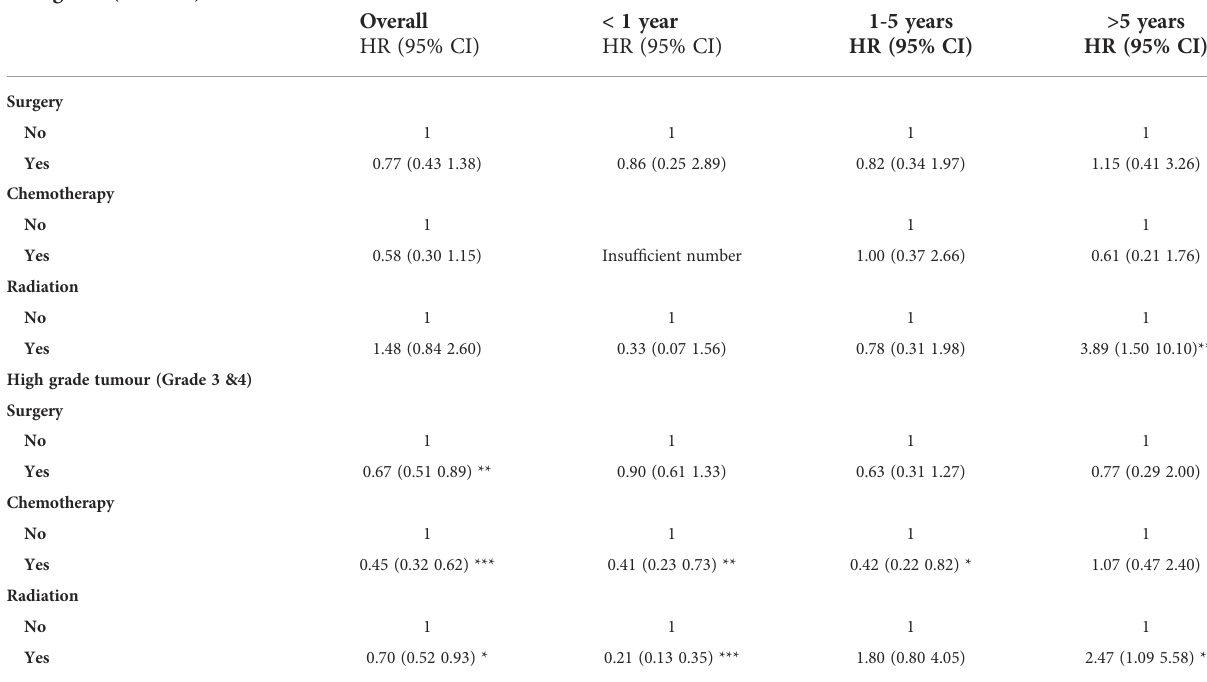
TABLE 3 Association of cancer treatment with cerebrovascular mortality in glioma patients by different follow-up periods strati fi ed by low grade and high grade. Low grade (Grade